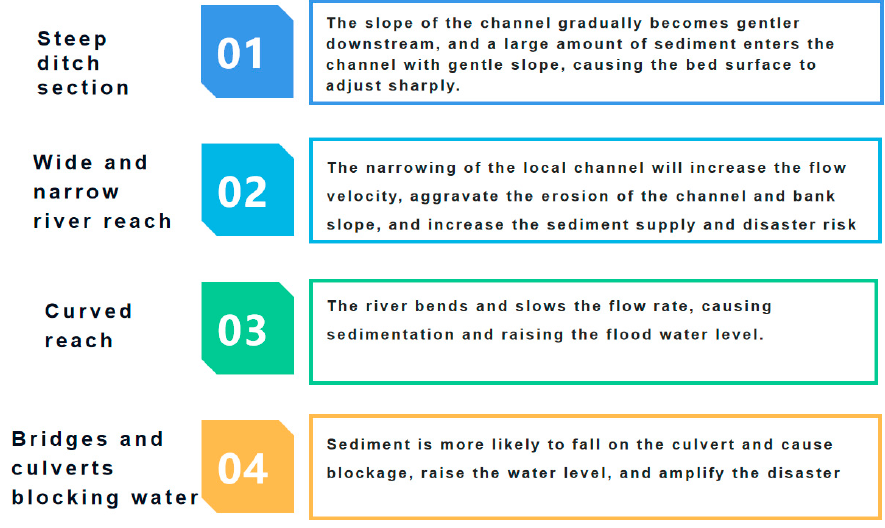
Figure 15. Typical siltation-prone river reach.